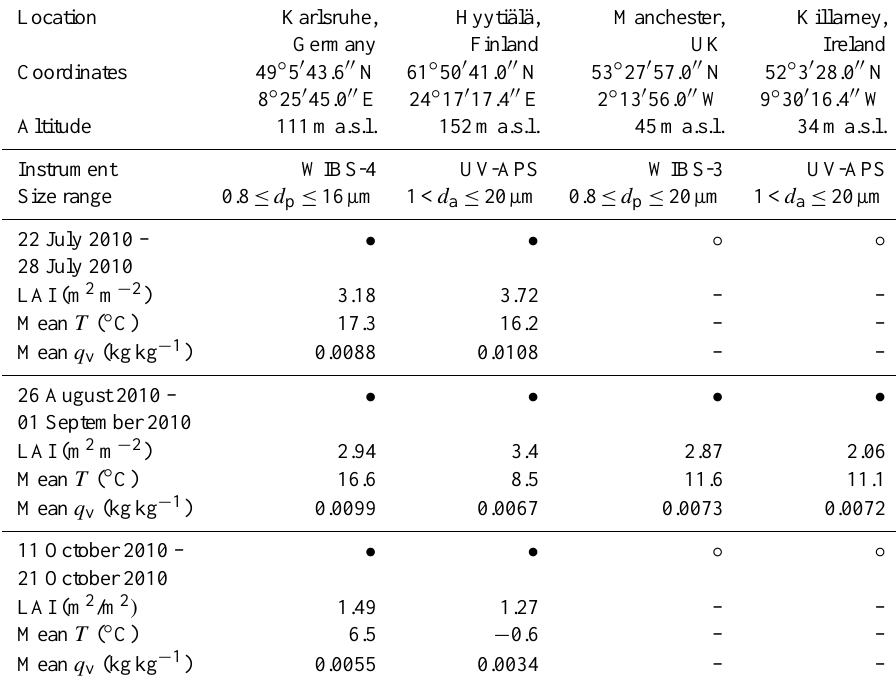
Table 1. Overview of the measurement sites, including their geographical location and the types of instrument used ( d p corresponds to the optical particle diameter and d a to the aerodynamic particle diameter). The sections below show the simulation periods and the availability of data at this site (filled dot). Mean values for the simulated meteorological and surface conditions used for the new emission parameterization (Sect. 3.2) at the measurement site during the corresponding time periods are added to each